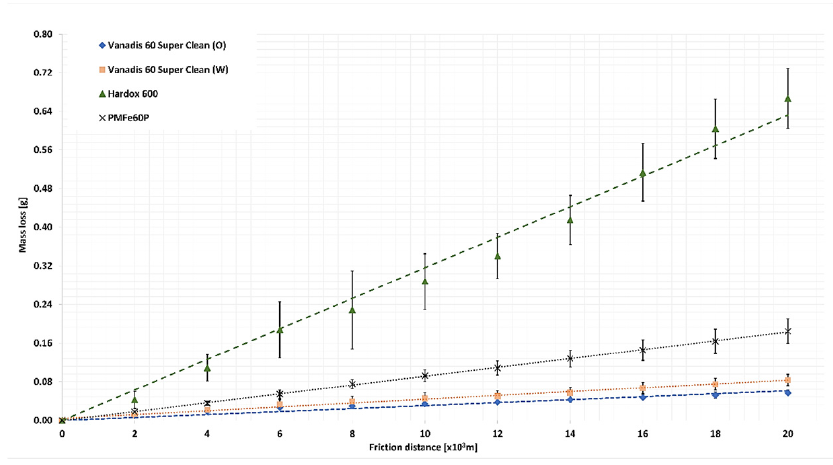
Figure 9. The course of weight loss for the test materials in the light soil.